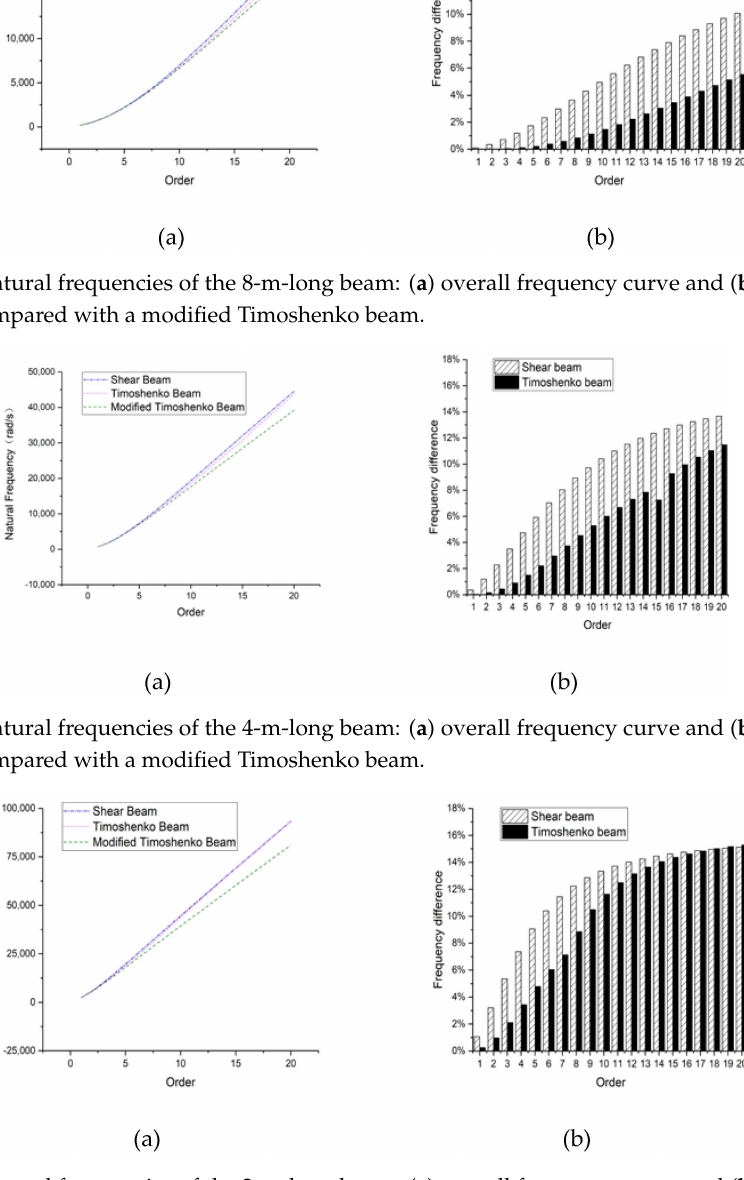
Figure 27. Natural frequencies of the 2-m-long beam: ( a ) overall frequency curve and ( b ) frequency di ff erence compared with a modified Timoshenko